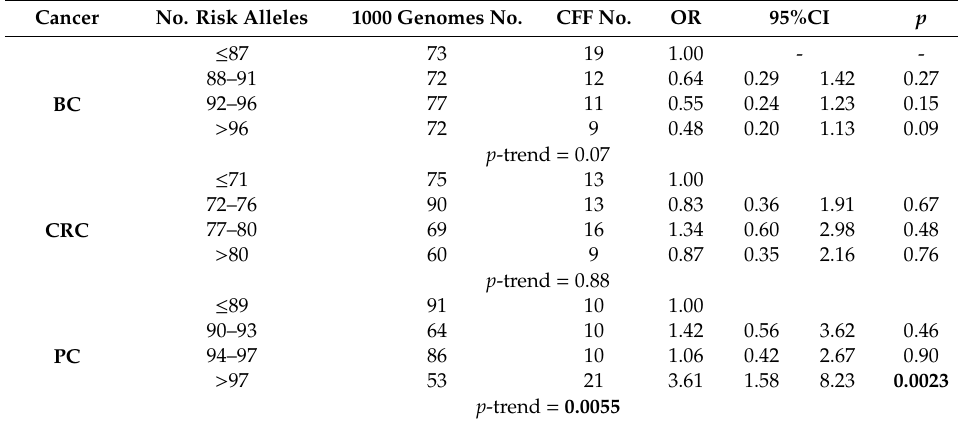
Table 2. Combined e ff ect of risk alleles related to breast, colorectal, and prostate cancers in cancer-free families (CFFs) and 1000 Genomes